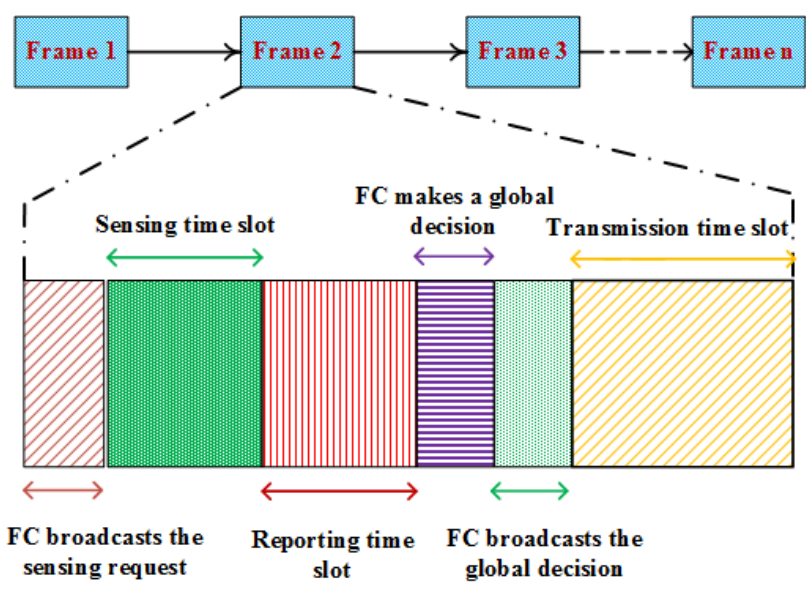
Figure 2. The frame structure of the proposed